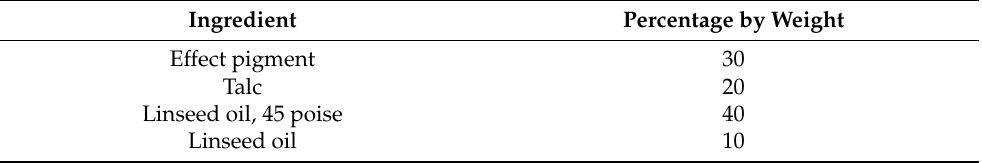
Table 2. Typical recipe for lithographic inks with effect pigments as colorant. Ingredient Percentage by Weight Effect pigment 30 Talc 20 Linseed oil, 45 poise 40 Linseed oil 10